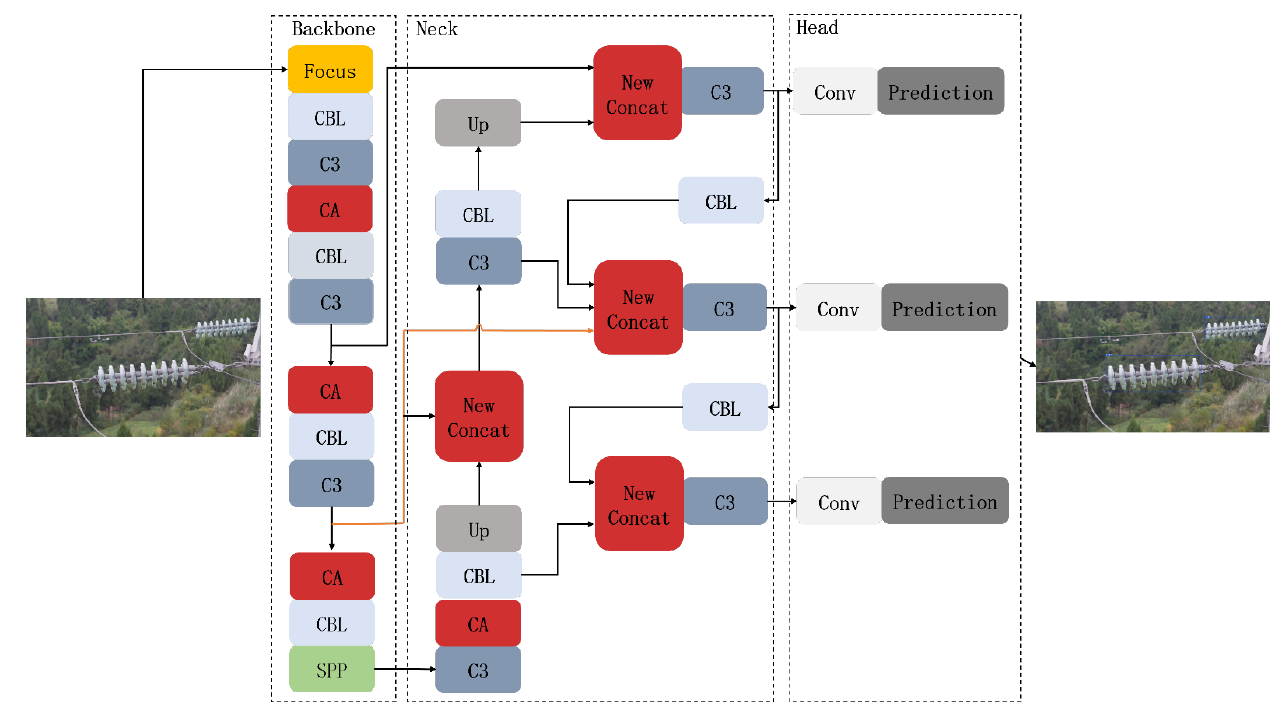
Figure 10. Architecture of the BC-YOLO